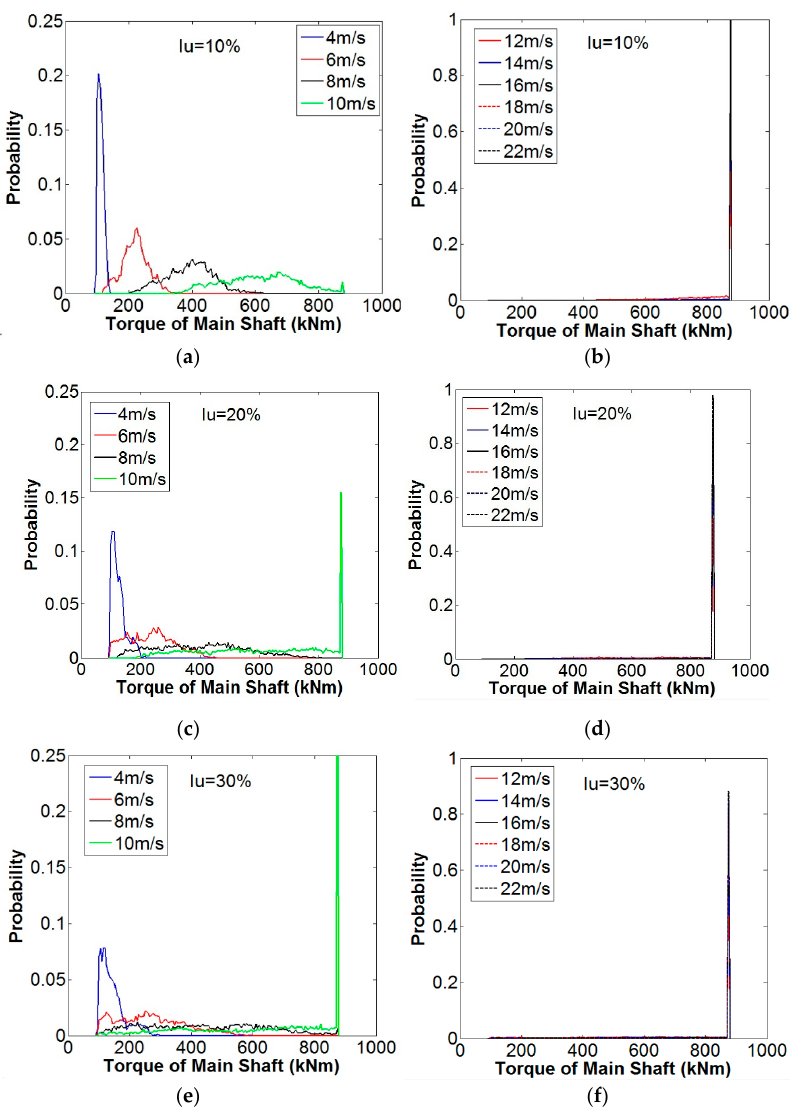
Figure 6. Time domain: ( a ) wind speed with mean value = 4–10 m/s, Iu = 10%; ( b ) corresponding torque of main shaft; ( c ) wind speed with mean value = 12–22 m/s, Iu = 10%; ( d ) corresponding torque of main shaft.